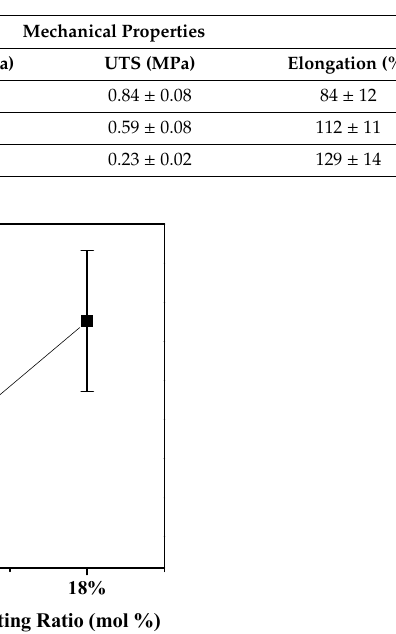
Figure 4. Comparison of swelling ratio of c(PGS-g-Arg) films with varying grafting ratios ( n = 3).